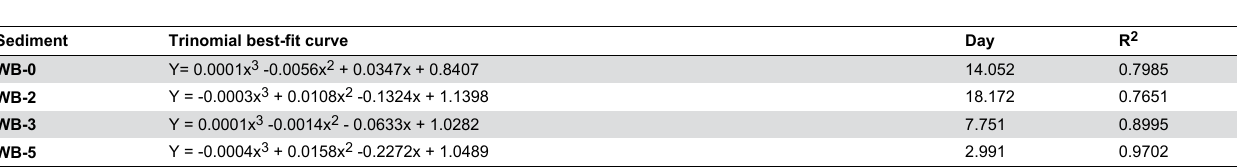
Table 6. Best fit curves for survivorship as a function of time (days).